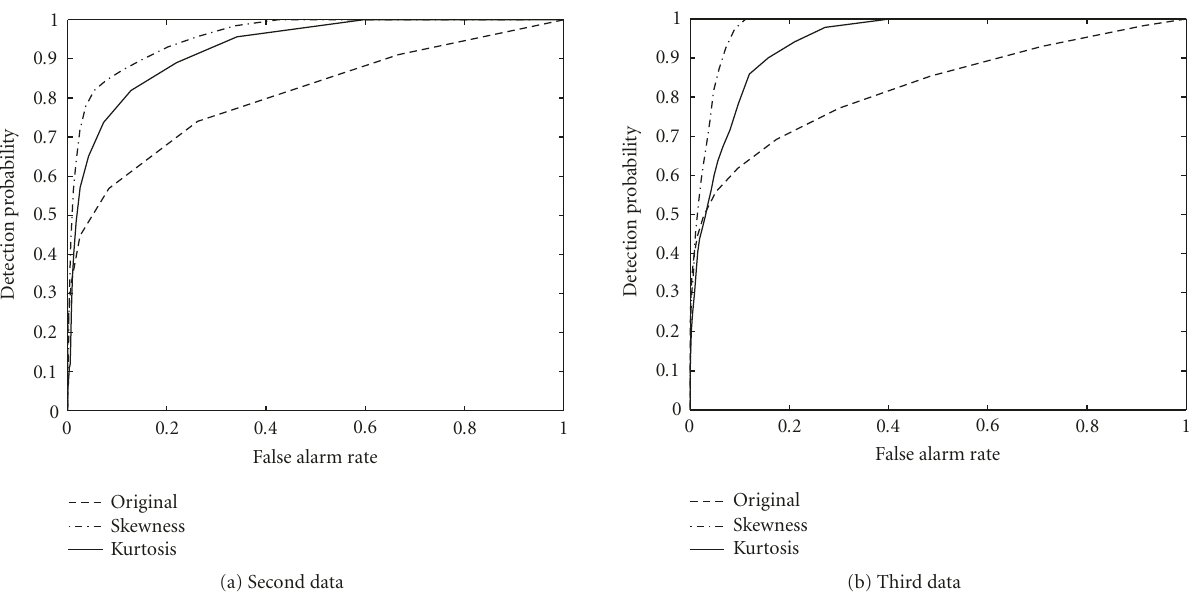
Figure 23: Performances of the HOS on the second and third SAS data compared with an amplitude threshold.